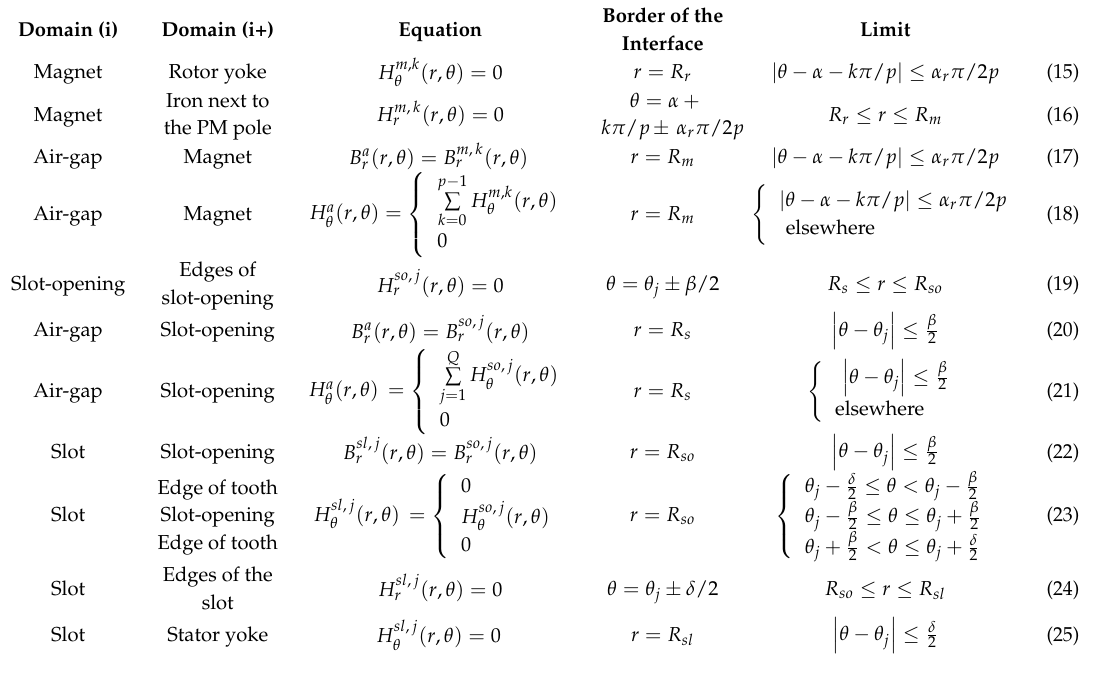
( b ) Figure 4. Value of the current density in each sub-region of slot, according to represented winding configurations. 2.5. Extracting the Fourier Series of the Magnetization In the 2-D polar coordinate system, the magnetization vector only has the radial and tangential components as Equation (32).